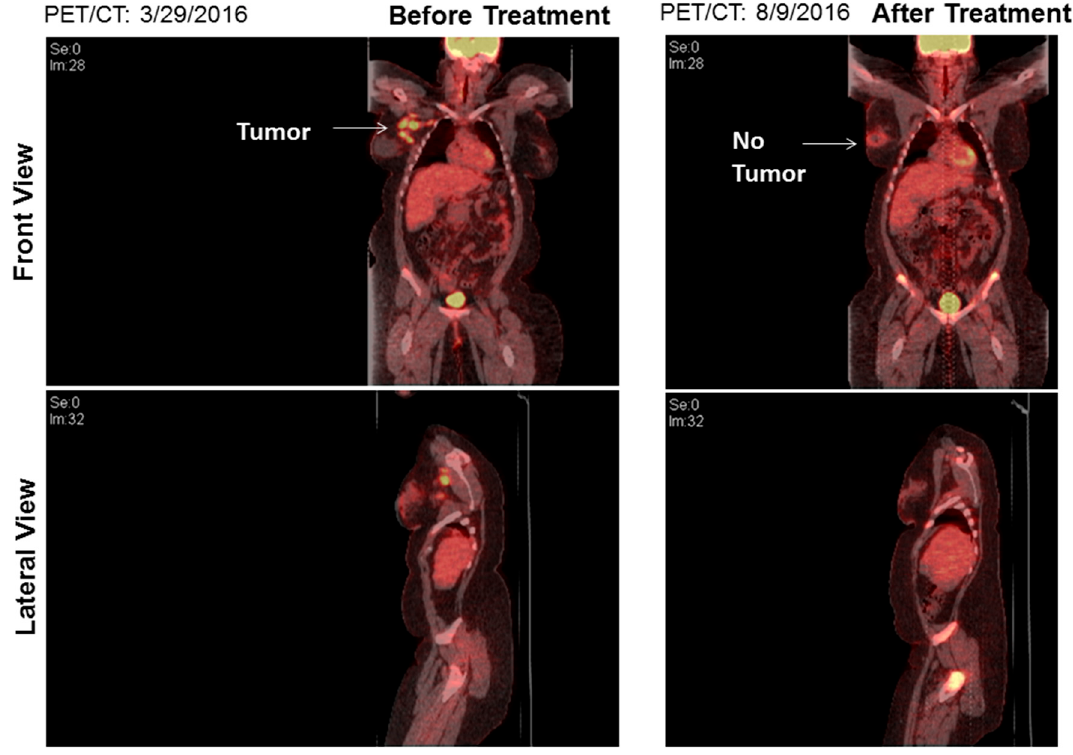
Figure 4. PET/CT of the tumor before ( left panel) and after ( right panel) the treatment. The right panel shows no evidence of tumor.